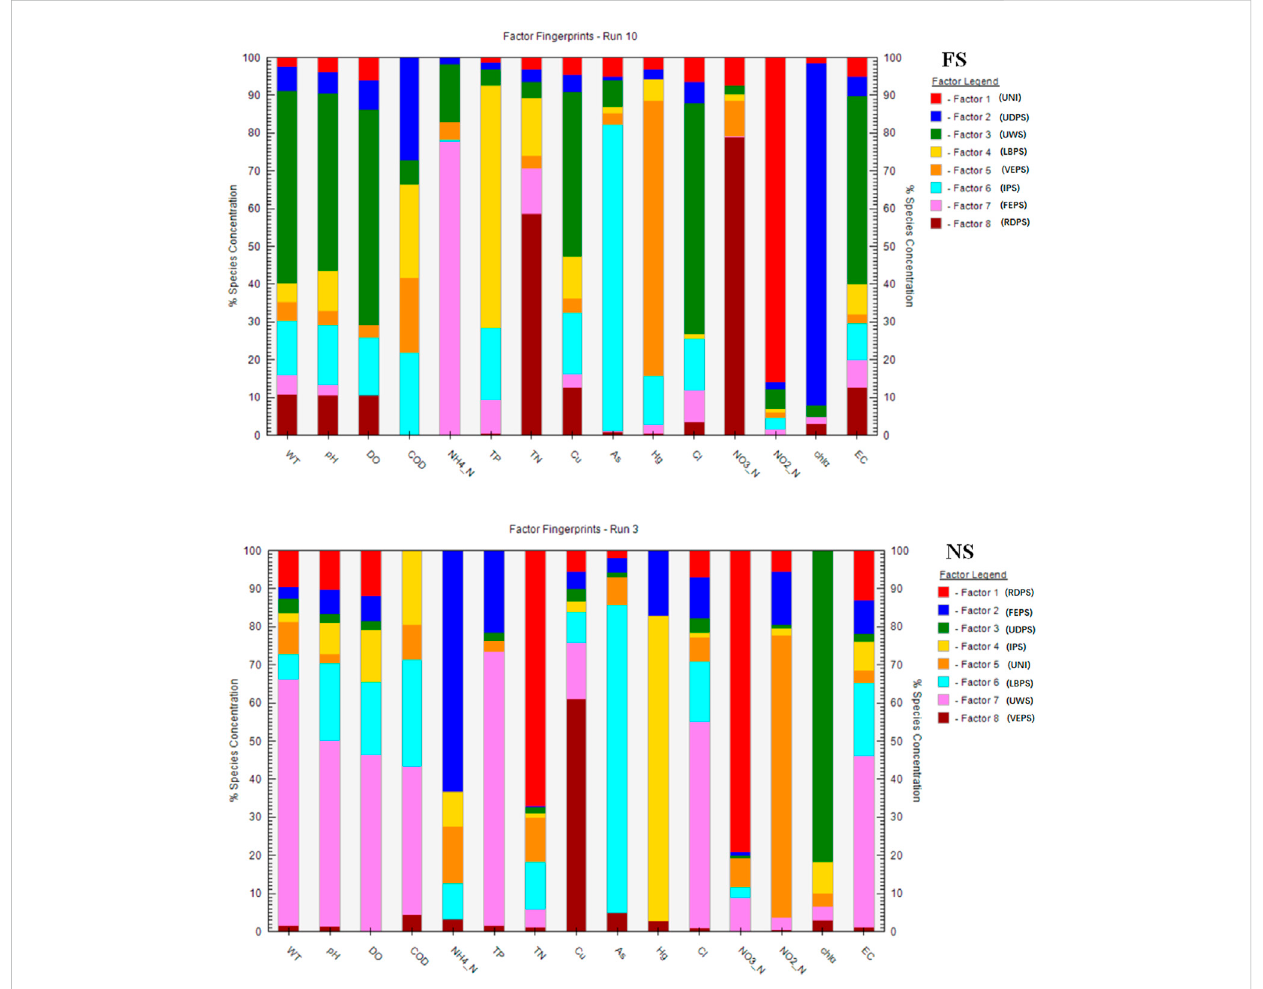
The Box plots of DO, EC, WT, and WQI in different seasons (the acceptable condition is DO ≥ 5